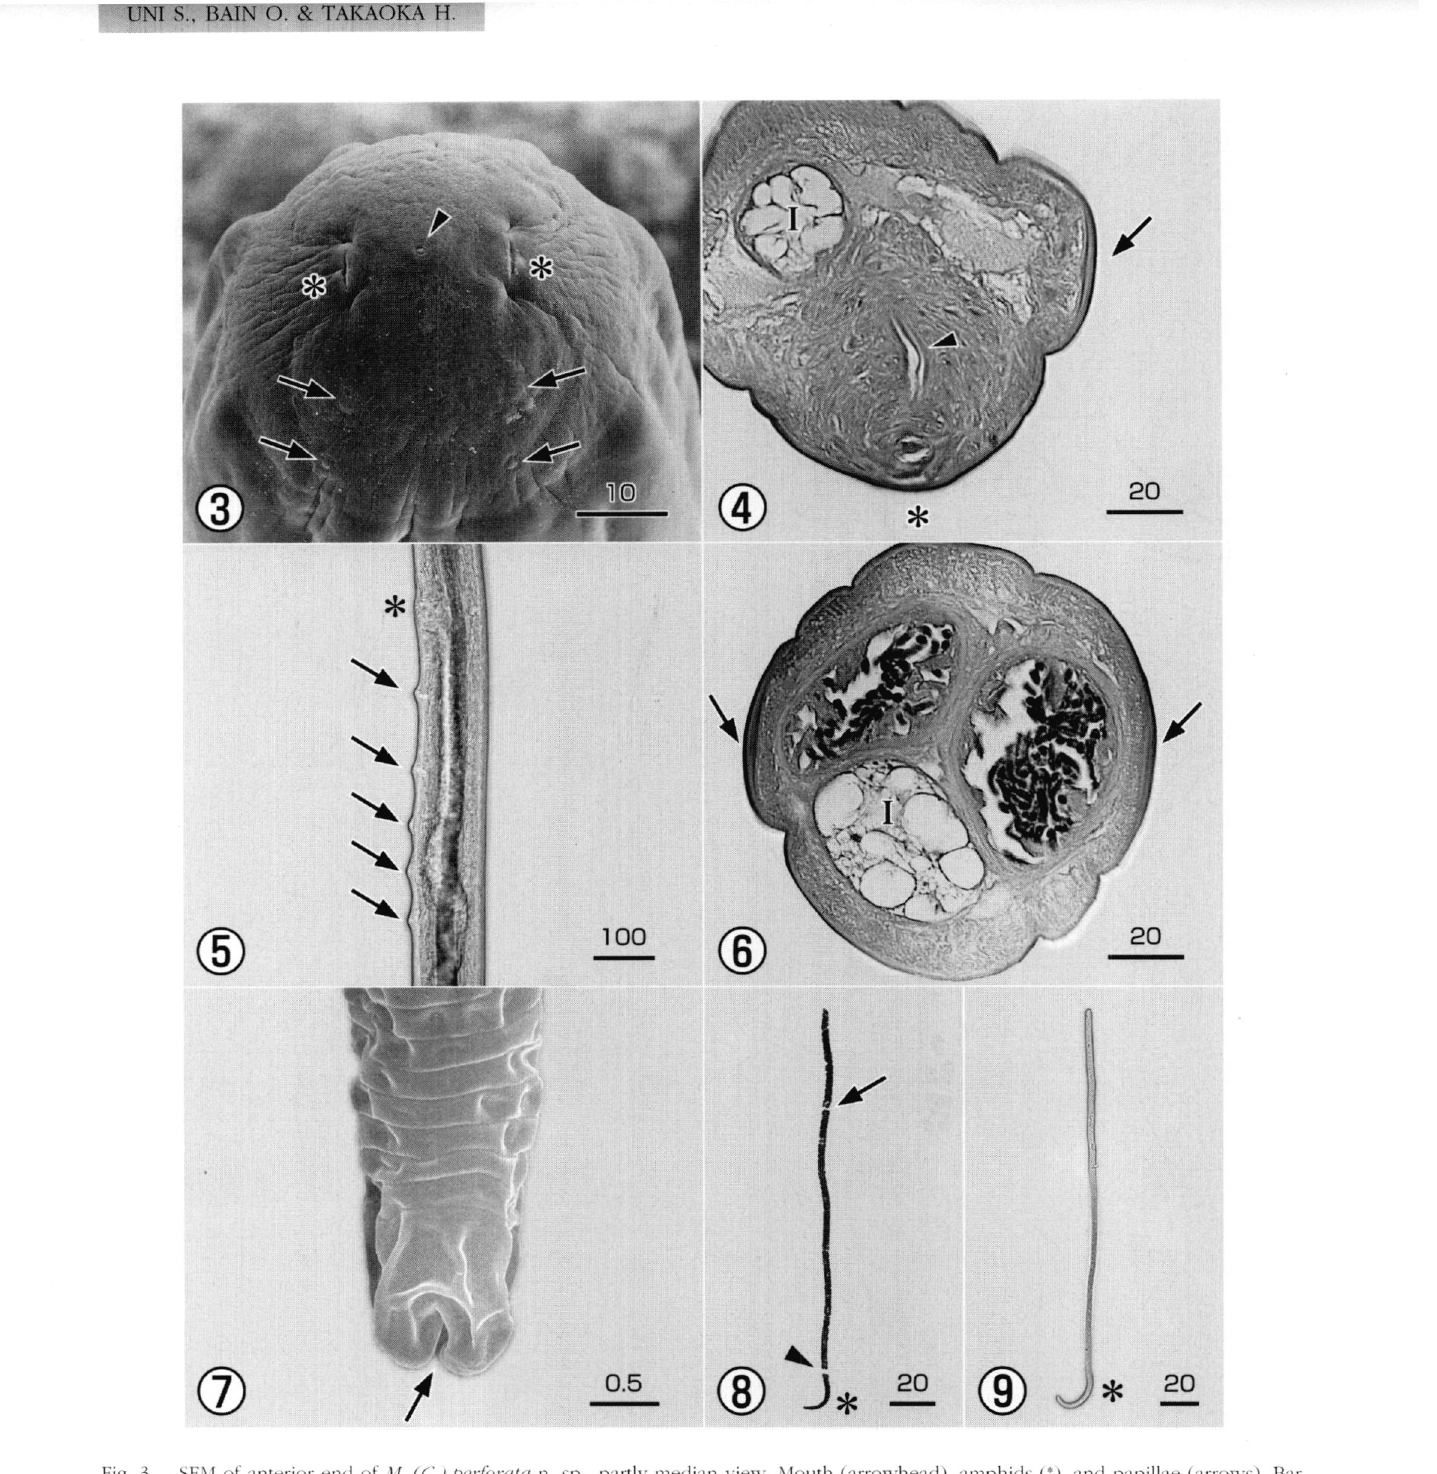
Fig. 3- - SF.M of anterior end of .1/. ( C.) perforata n. sp.. partly median view. Mouth (arrowhead), amphids (*). and papillae (arrows). Bar. micrometers. Fig. 4. - Transverse section of .1/. ( C.) perforata n. sp. at the level of the vulva. Vulva (*). vagina uterina (arrowhead), thick cuticle at lateral field (arrow), and intestine (I). Bar, micrometers. Fig. 5. - Vulva (*) and cuticular pores (arrows) of a female M . (C.) perforata n. sp. seen by differential interference contrast microscopy, lateral view. Bar, micrometers. Fig. 6. - Transverse section of anterior part of female M . (C.) perforata n. sp.. microfilariae in uteri, thick cuticle at lateral fields (arrows), and intestine (I). Bar, micrometers. Fig. 7. - SFM of the posterior end of a microfilaria of .1/. (C.)perforata n. sp., bifid end (arrow) in ventral view. Bar, micrometers. Fig. 8. - Microfilaria taken from ovejector of a female M. (C.I perforata n. sp., stained with Giemsa's solution. Nerve ring (arrow), anus (arrowhead), and curved posterior part (*). Bar. micrometers. Fig. 9. - Microfilaria of M. (C.) perforata n. sp. taken in the preparation of a skin snip from the midback of sika deer, differential interfe rence contrast image. Crook-shaped tail (*). Bar.